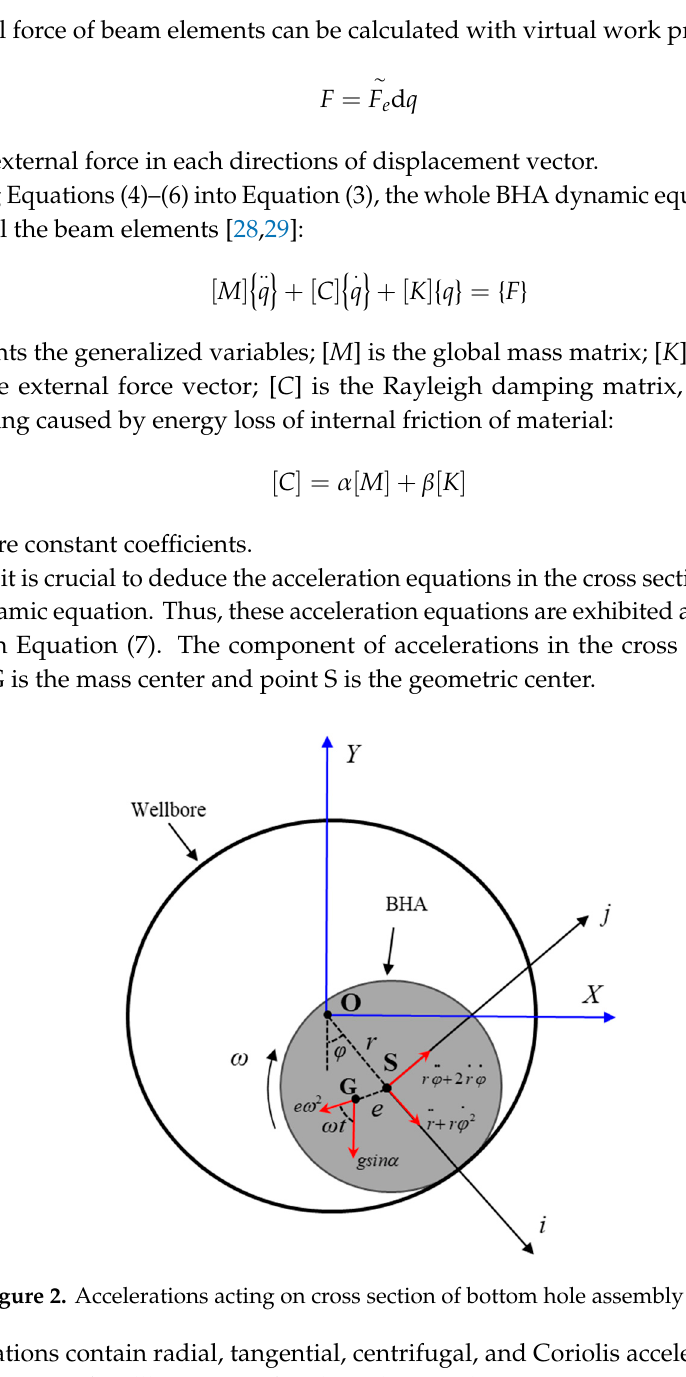
Figure 2. Accelerations acting on cross section of bottom hole assembly (BHA).